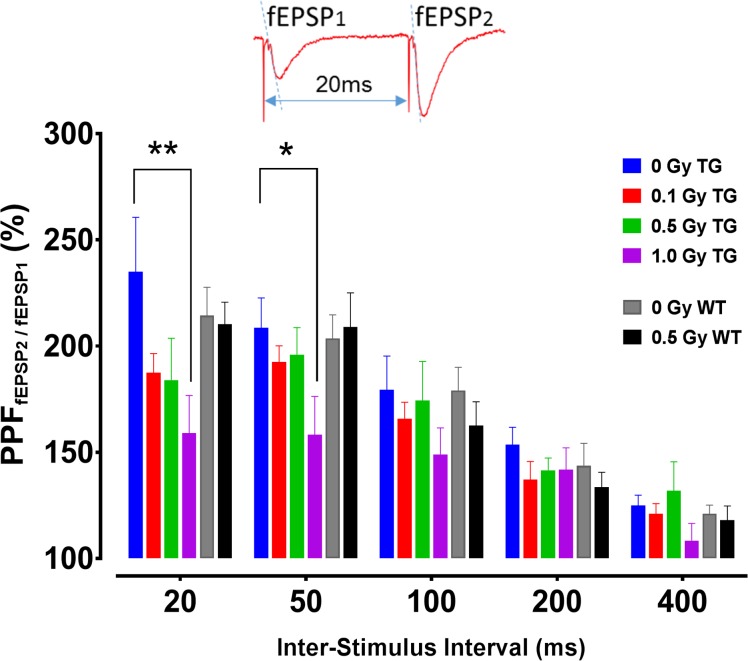
PPF in CA1 neurons of TG and WT mice 9 months post-irradiation.PPF ratios are shown at all tested inter-stimulus intervals (ISI) of 20–400 ms. Significant decrements in PPF were detected at 20 and 50 ms ISI in TG mice exposed to 1 Gy. Inset: Original voltage trace of PPF at 20 ms ISI showing facilitated slope of the 2nd fEPSP (fEPSP2). Arrowheads indicate ISI between stimulation artifacts. Paired-pulse stimulation leads to facilitation of the fEPSP2. TG mice: N = 12, 15, 7 and 10 slices/radiation group; WT mice: N = 16, 14 slices/radiation group. Statistical analyses: RM ANOVA, Post hoc ** p<0.01, * p<0.05. Data represent means ± SEM.